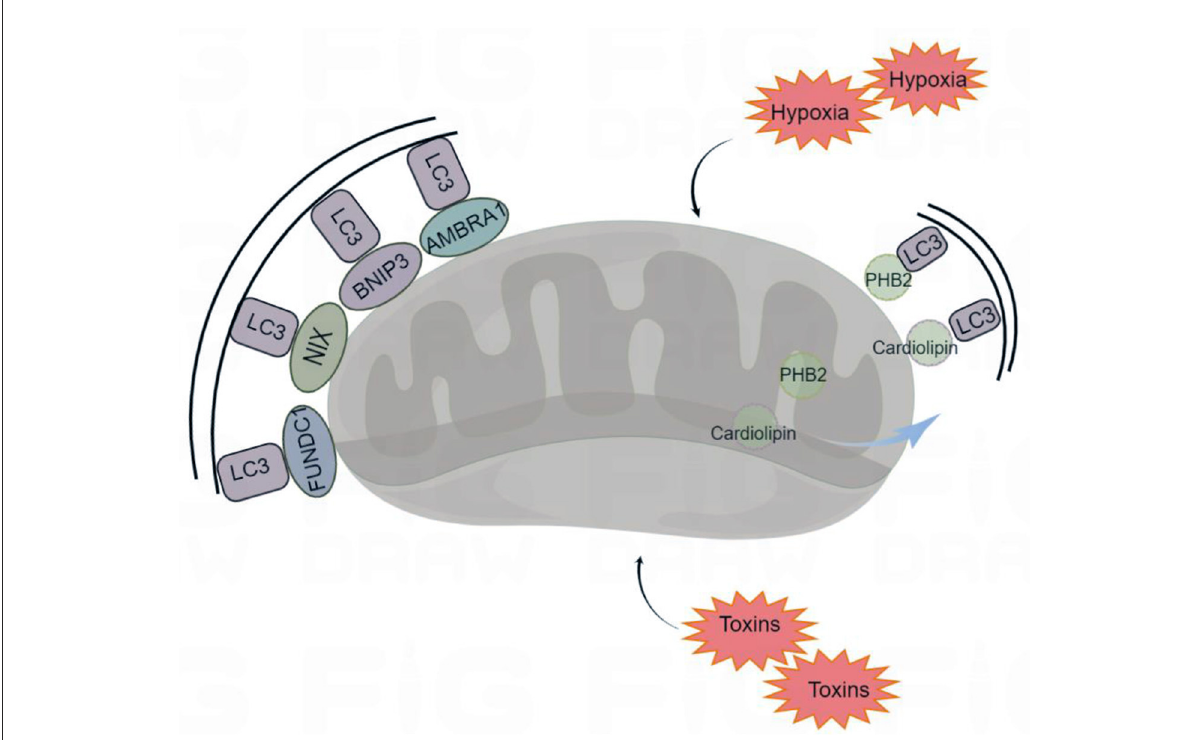
FIGURE2 Receptor-mediated mitophagy. Under certain conditions (hypoxia and toxins) mitophagy receptors are activated. The mitophagy receptors containing LIR (LC3-interacting region) motifs, such as FUNDC1 (FUN14 Domain Containing 1), BNIP3 (BCL2 Interacting Protein 3), NIX (Nip3-like protein X), AMBRA1 (Activating Molecule in Beclin1-regulated Autophagy), PHB2 (Prohibitin 2), and cardiolipin, interact with the autophagosome light chain 3 (LC3), targeting the damaged mitochondria for mitophagy. By Figdraw